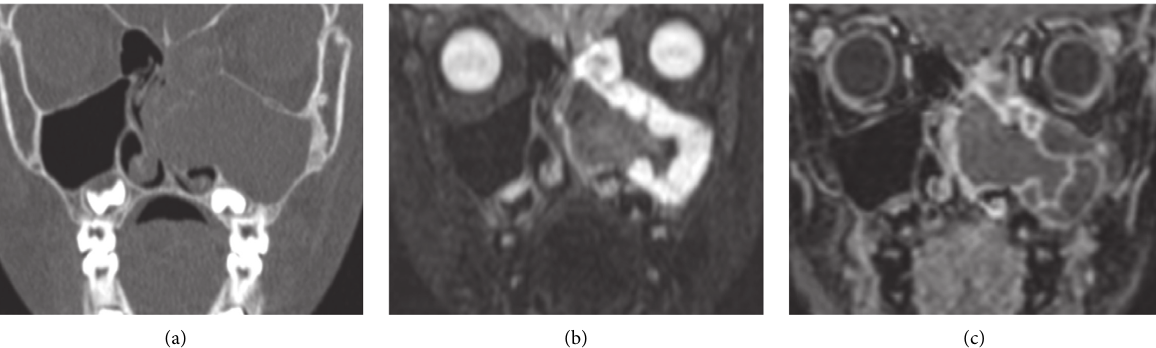
Figure 5: Fungal sinusitis in 7-year-old male with symptoms of nasal obstruction. (a) Coronal unenhanced CTdemonstrates left ostiomeatal pattern opacification with maxillary mural osteitis plus expansion of maxillary antrum. This appearance is equivocal and could represent chronic rhinosinusitis, fungal sinusitis, or tumour. However, low signal centrally on (b) coronal STIR, surrounded by peripherally en- hancing thickened mucosa on (c) coronal contrast-enhanced T1W, is consistent with a left maxillary into middle meatal mycetoma and maxillary